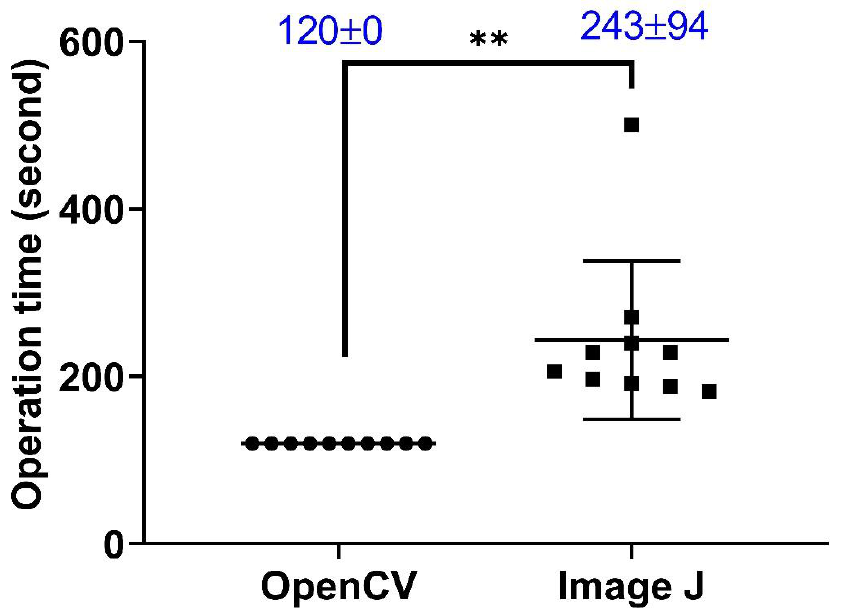
Figure A1. Comparison of calculation speed between OpenBloodFlow and ImageJ methods. Zebrafish embryos aged at 3 dpf were subjected to blood flow velocity measurement using either OpenCV or ImageJ methods. Sample size n = 10. The data were shown as mean with standard deviation, and statistical significance was determined by paired t -test comparison (** p < 0.01, n = 10). (circle dots show the data analyzed by OpenCV, while square dots show the data analyzed by ImageJ).